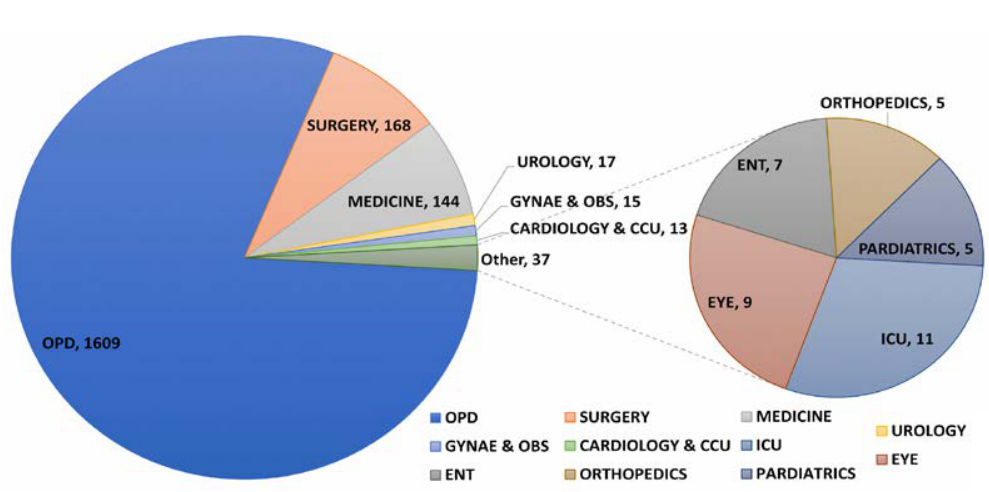
Fig. 1. The frequencies of samples received from different departments and tested for HBsAg and Anti-HCV. Gynae & OBS; Gynaecology and Obstetrics, CCU; Coronary Care Unit, ICU; Intensive Care Unit, ENT; Ear, Throat and Nose, OPD; outdoor patients